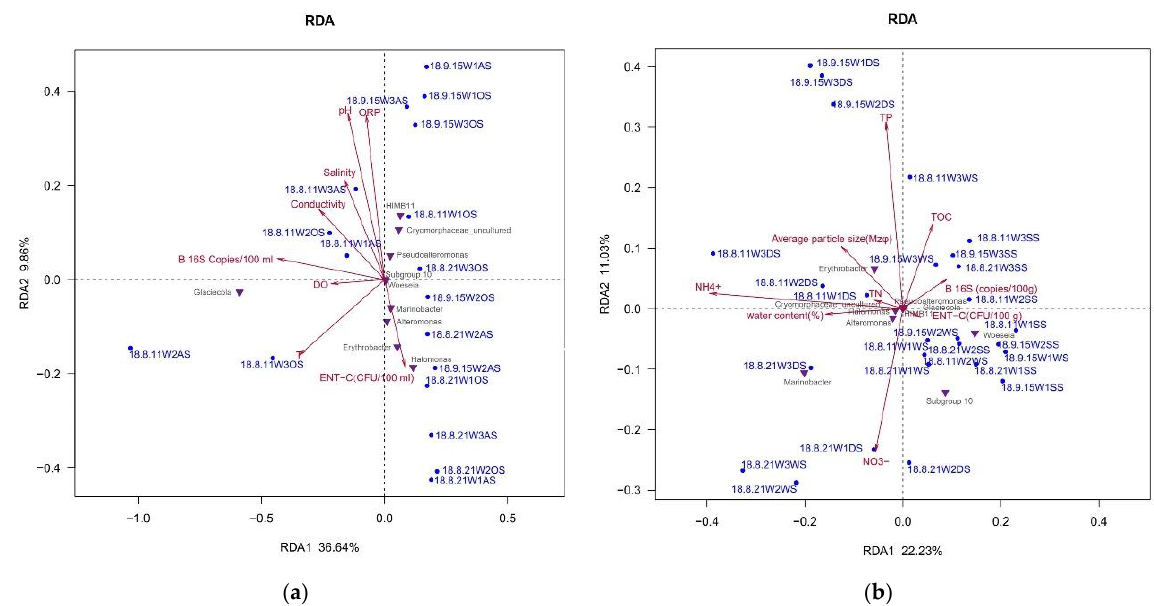
Figure 7. RDA showed the relationship between physical-chemical parameters and the top ten bacterial genera in Jinshitan Bathing Beach. ( a ) Seawater; ( b ) beach sand. RDA showed that nutrient and sand particle size explained 33.26% of the total vari- ance of the bacterial community in beach sand (Figure 7b). The permutation test showed that total nitrogen ( p > 0.05), NH 4+ ( p < 0.05), and NO 3 – ( p > 0.05) were the main factors impacting bacterial community structure, followed by TOC and sand particle size ( p > 0.05). The abundance of total bacteria and cultivable enterococci contributed little to the bacterial community structure variance in beach sand. 4. Discussions The impact of typhoons and heavy storms on the water quality of marine bathing beaches has not been well studied due to the apparent geographical heterogeneity of bac- terial pollution. In this study, one typical typhoon event in 2018 was tracked, and the change in bacterial community structure, FIB abundance, and specific taxa of fecal pollu- tion was evaluated in seawater and beach sand samples. Furthermore, the restructuring of the bacterial community and driven factors were also assessed. 4.1. Effects of the Typhoon on Water Quality The different typhoon impacts on water quality were observed based on FIB of en- terococci and fecal taxa. The cultivable enterococci increased in seawater (alongshore and